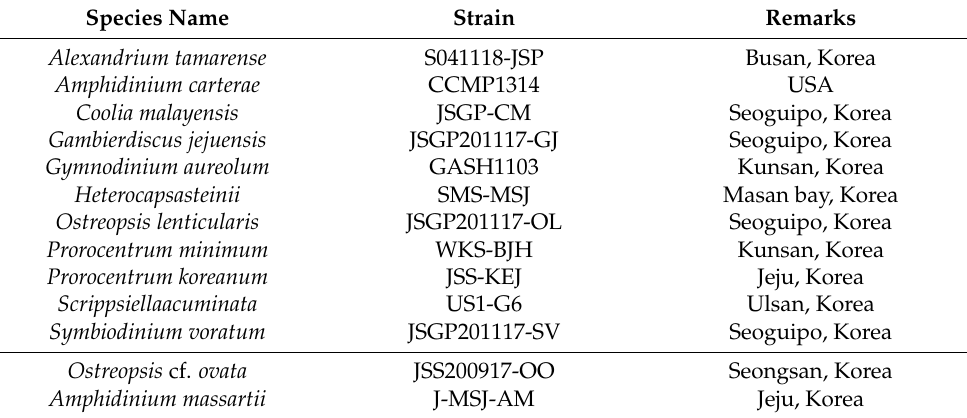
Table 3. List of dinoflagellate species used to confirm the species specificity of the two sets of LAMP primers ( O . cf. ovata and A. massartii